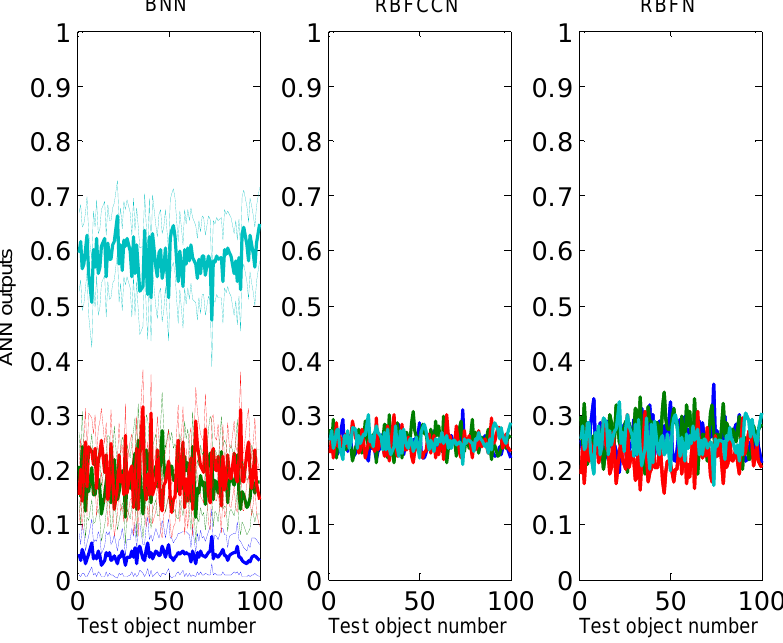
Figure 10. Average prediction outputs from the test set. BNN, RBFCCN and RBFN models were obtained by training each network 30 times. The 95% confidence intervals are indicated as the thin lines around the BNN outputs. Different colors represent excitations from different output